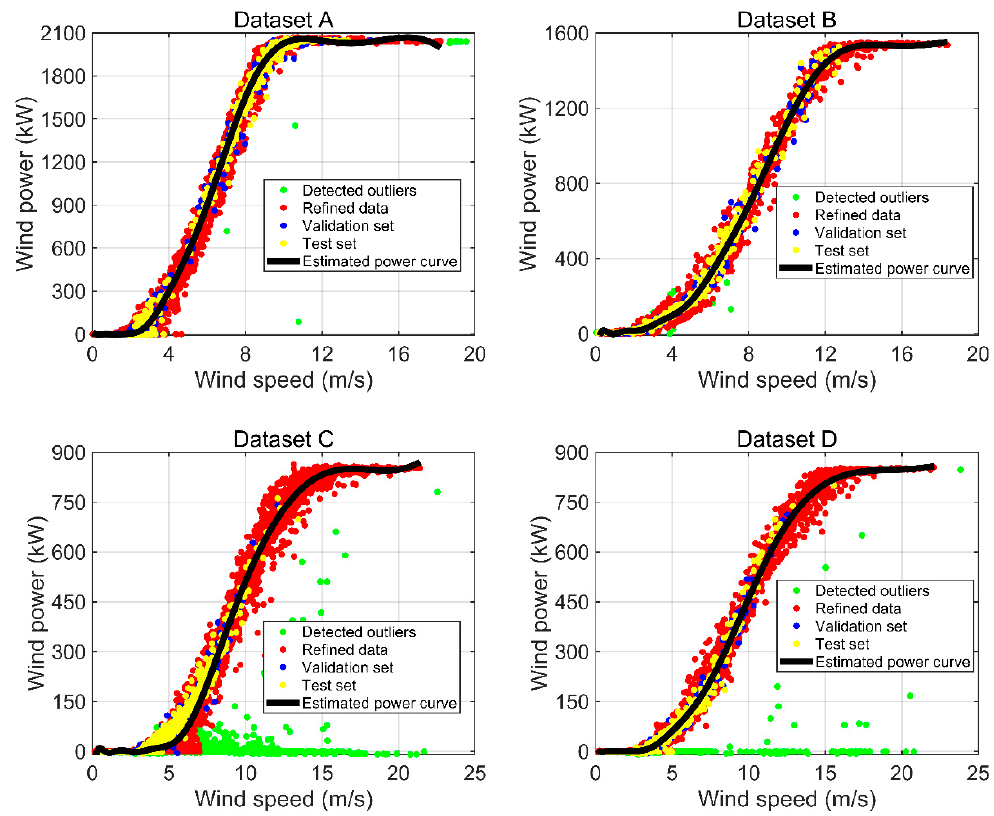
Figure 6. The estimated power curves for different wind turbines.